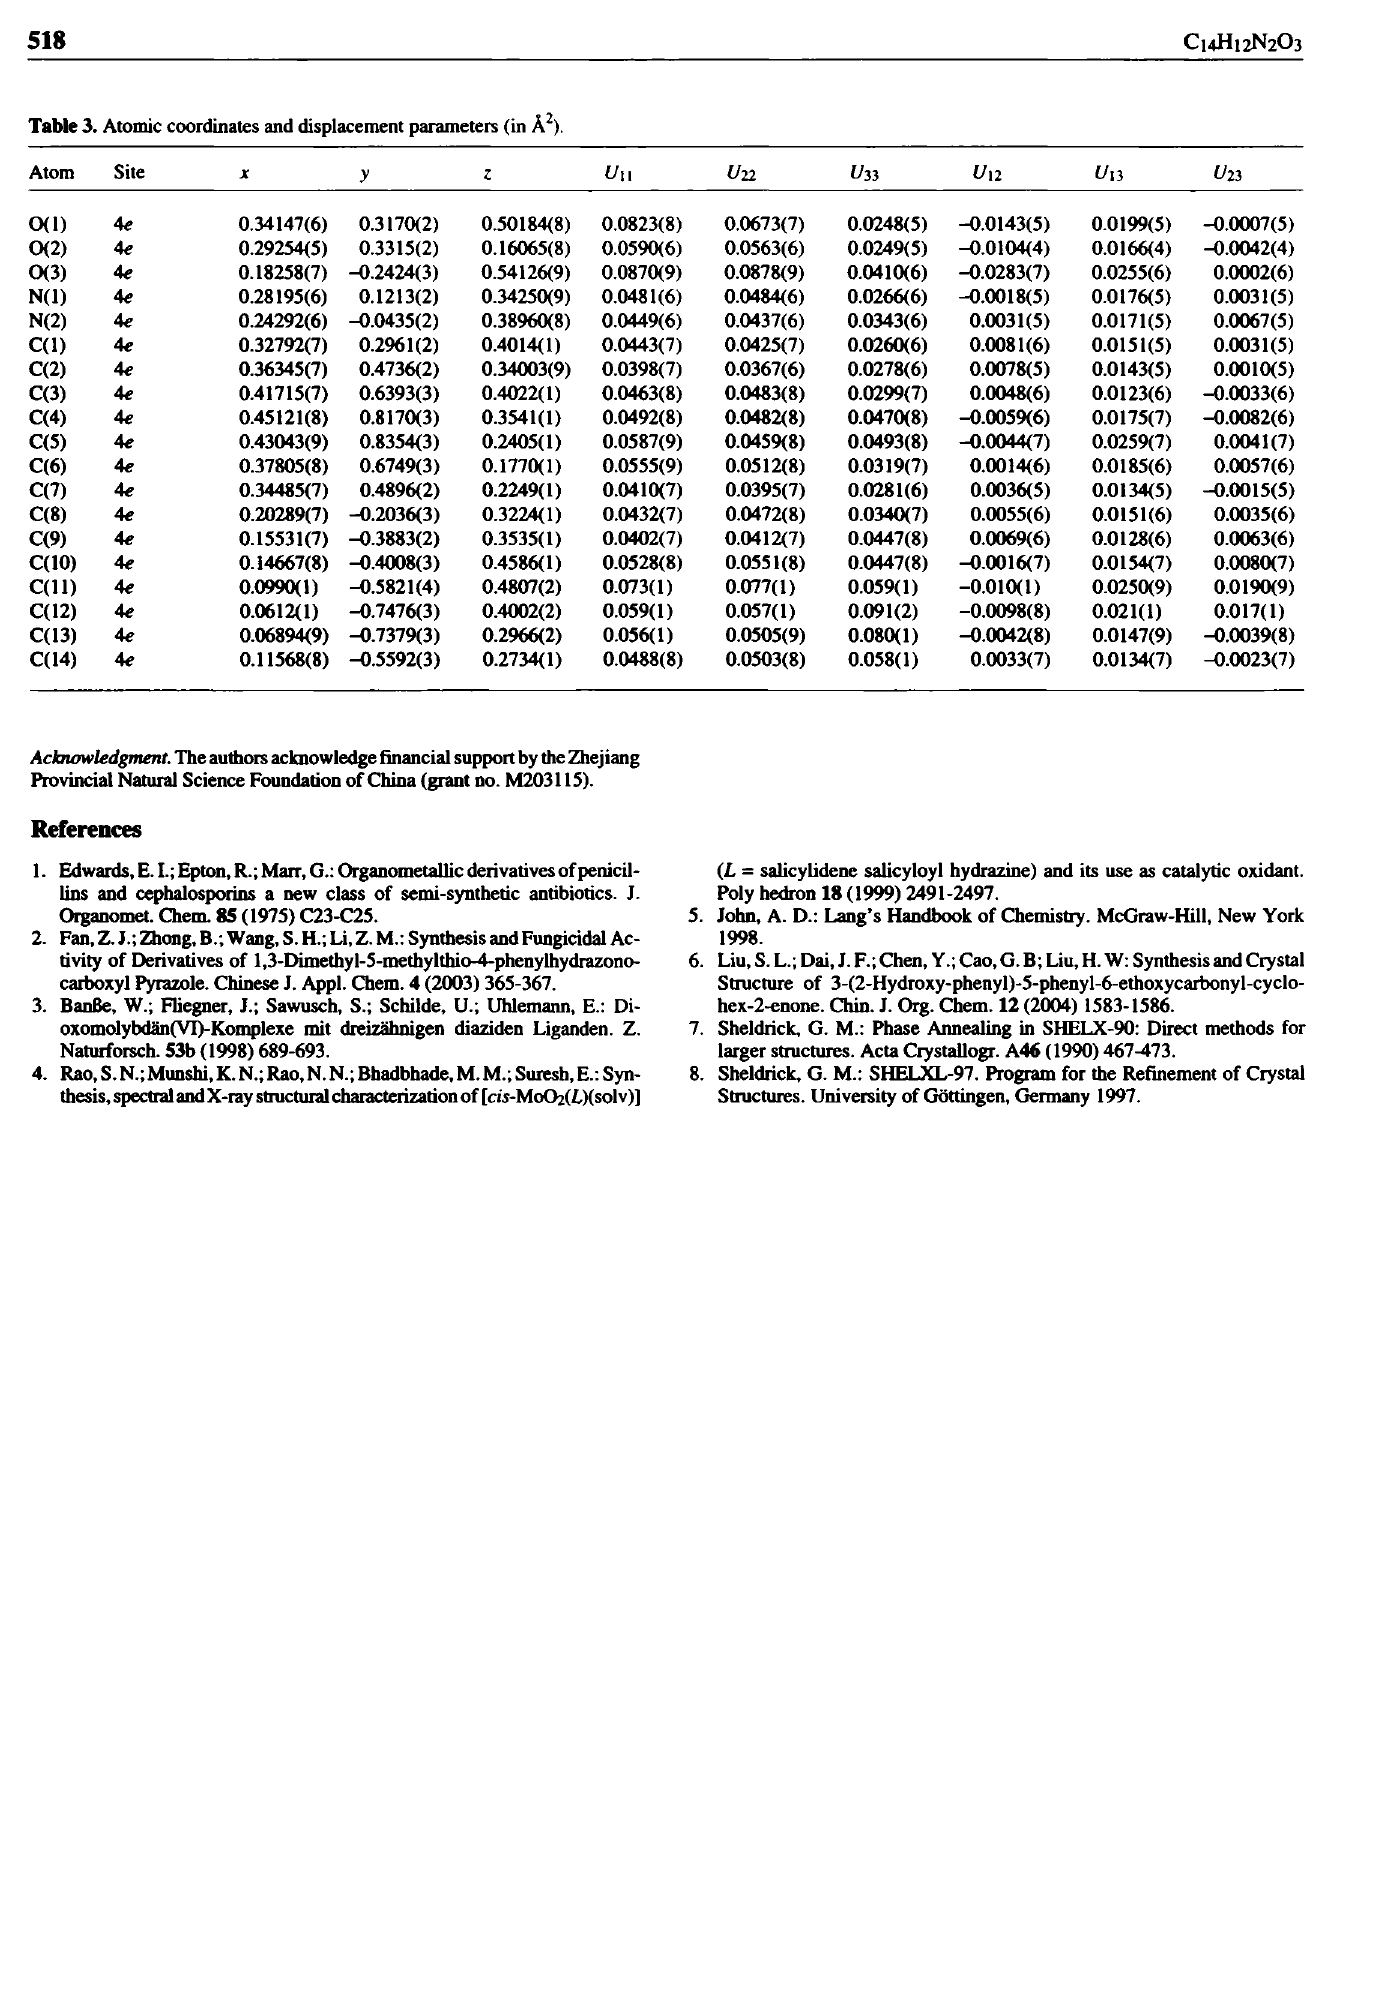
Table 3. Atomic coordinates and displacement parameters (in Ä 2